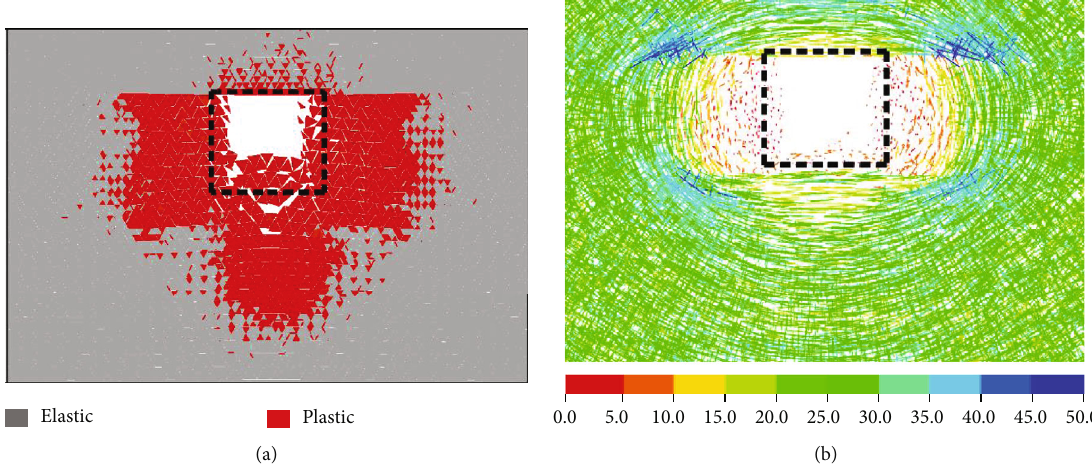
Figure 8: Reverse arching mechanism of the roadway fl oor. (a) Plastic zone and (b) stress tensors (MPa, colored by σ